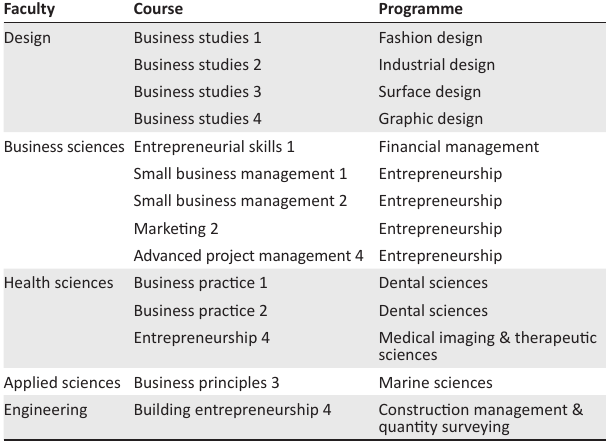
TABLE 1: Entrepreneurship education courses included in the